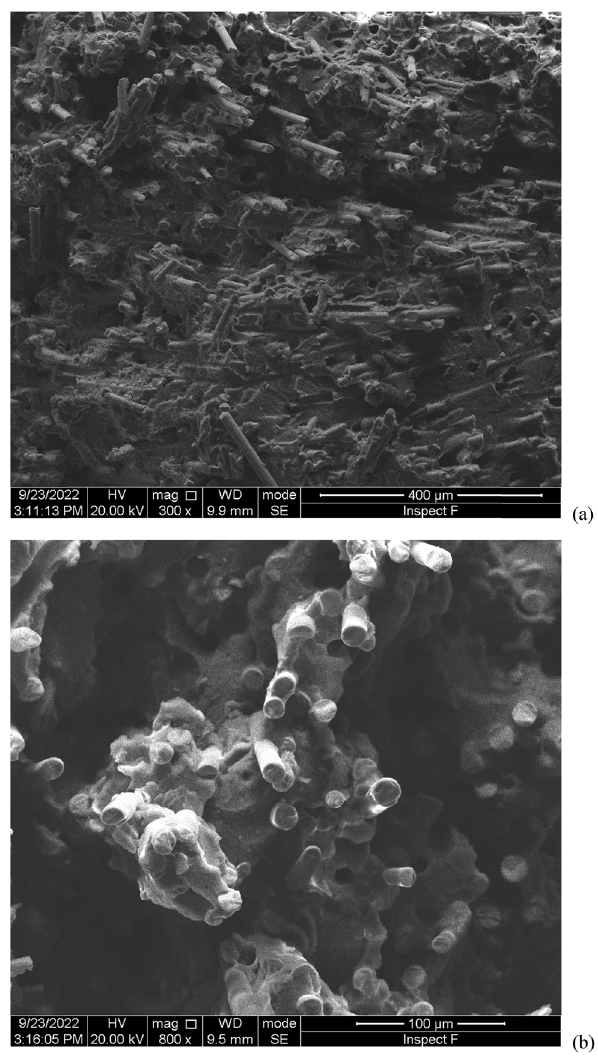
Figure 12: SEM images of the impact - fractured surfaces of H 40 T 10 G 50 composites ( a and b )